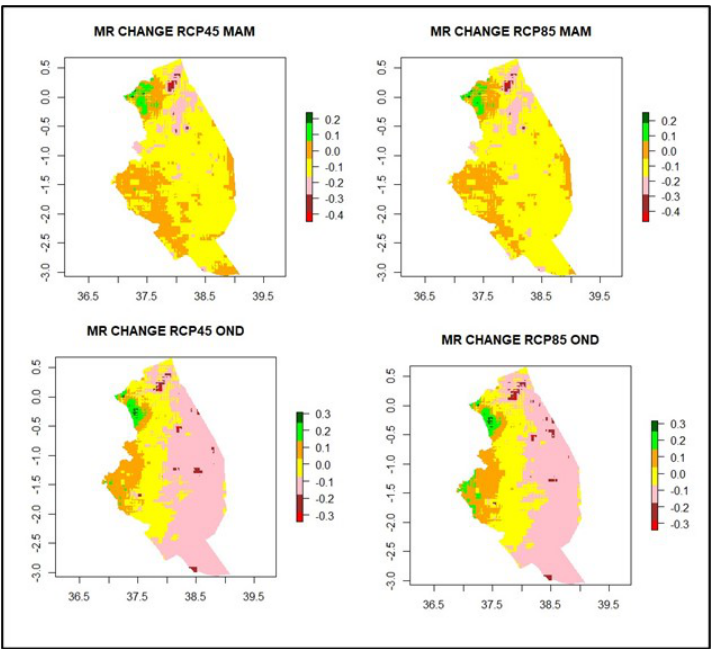
Figure 6. Changes in moisture index during MAM, OND in 2040 for RCPs 4.5 and 8.5.